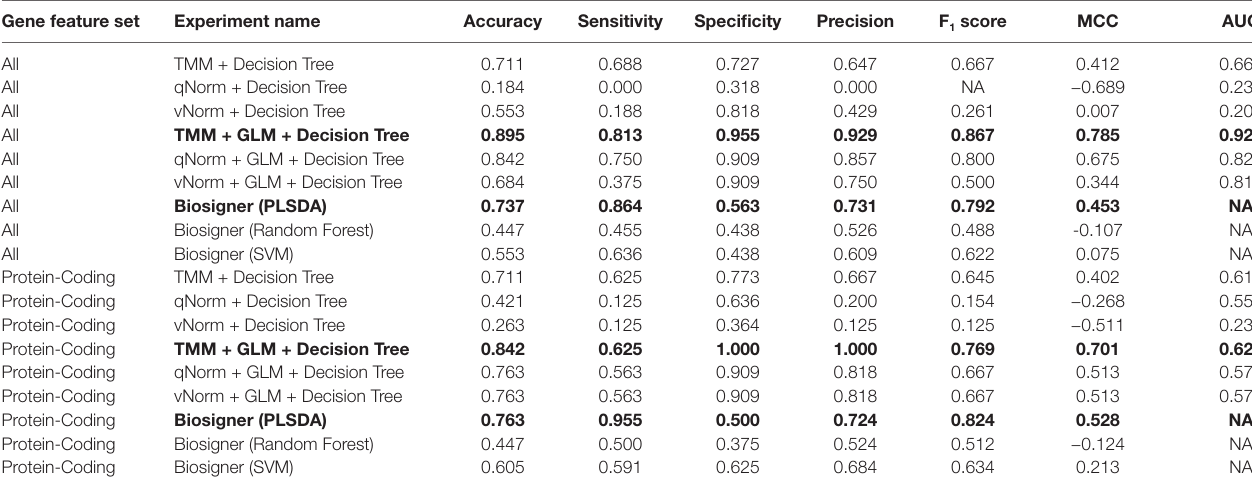
TABLE 5 | Performance measures using transcriptomics data by leave-one-out